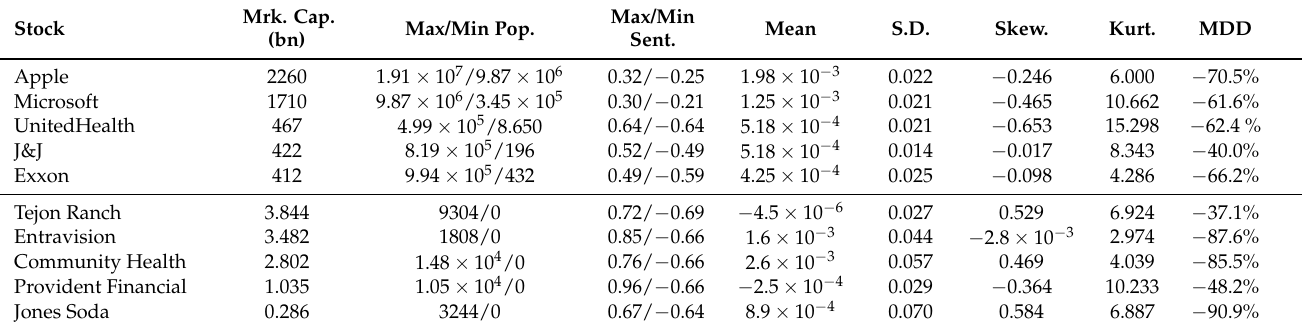
Table 1. Main information about the top 5 most/least capitalized stocks in the dataset. MDD stands for maximum